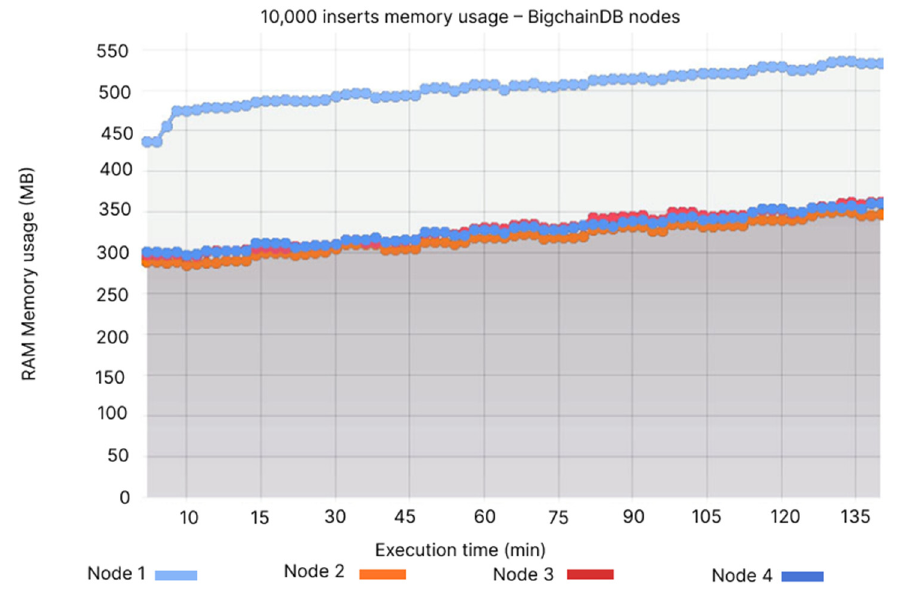
Figure 16. 10,000 inserts memory usage—BigchainDB nodes.